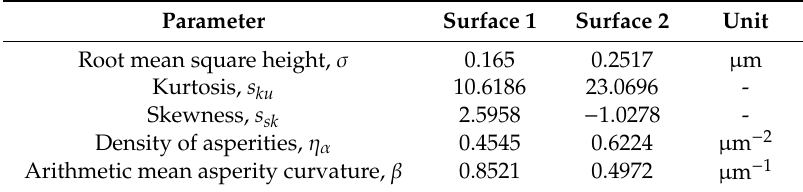
Table 2. The roughness parameters for the two measured